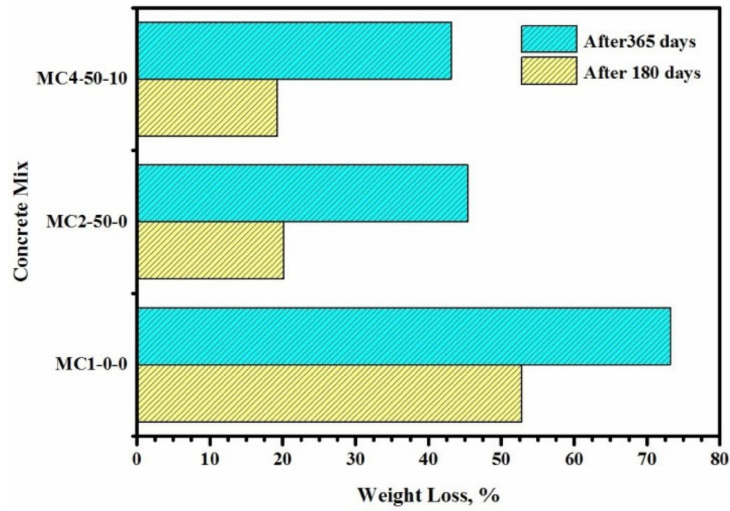
Figure 11. Influence of FA and EM on weight loss of the bio-concretes exposed to 10% of H 2 SO 4